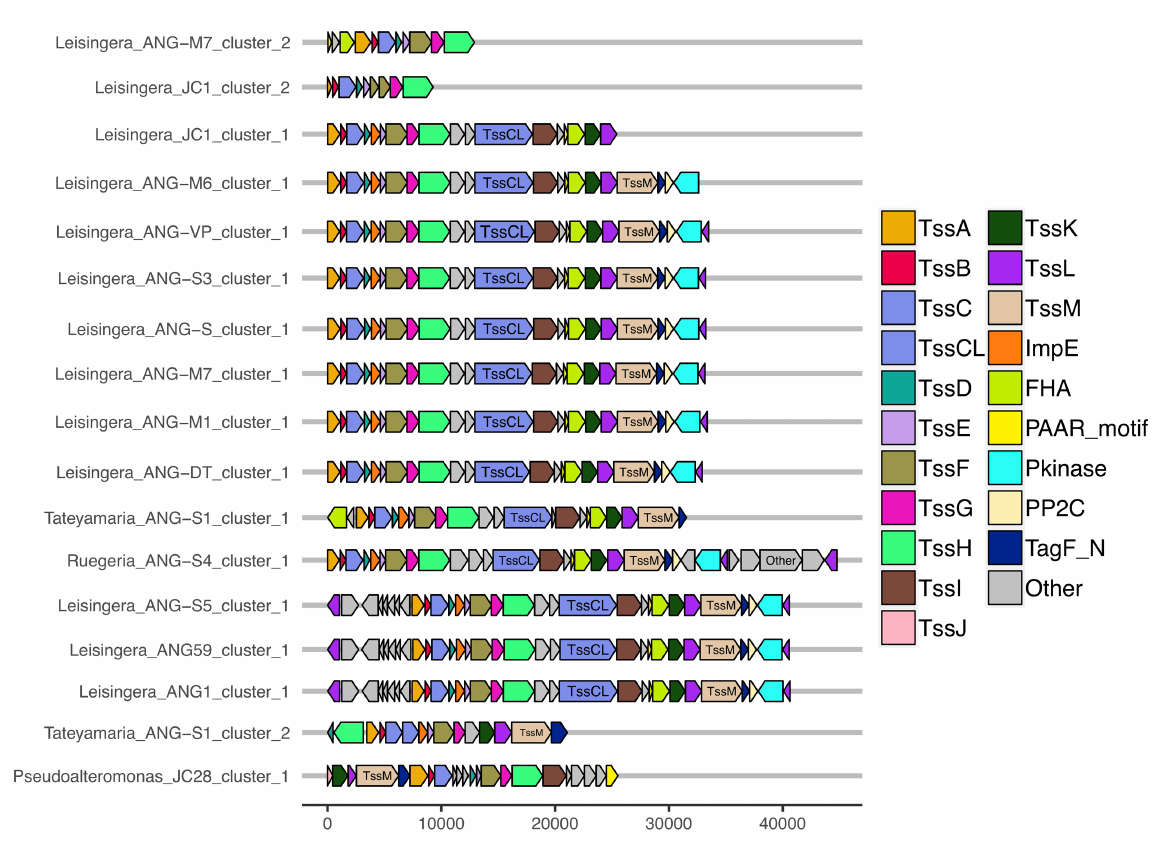
FIGURE 5 Gene organization of predicted T6SS clusters of Euprymna scolopes ANG bacterial symbionts. The roseobacter ANG symbiont genomes (all but Pseudoalteromonas sp. JC28) share similar T6SS accessory genes and cluster organization. These strains also share a second, long copy of the large sheath subunit, termed here TssC L , in their first T6SS clusters. TssC L was not detected in any genomes outside of the Alphaproteobacteria, and is absent from the Gammaproteobacteria ANG symbiont, JC28, shown here. Each of the T6SS core structural and accessory genes are colored, genes that have not been associated with a T6SS function are labeled as “other” and are gray. Genes are drawn to scale at bottom of figure, measured in